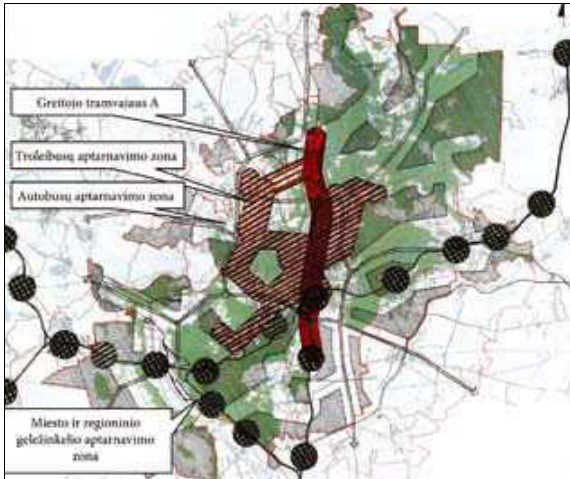
Fig. 6. Fragment of proposed version of integrated communication system in Vilnius